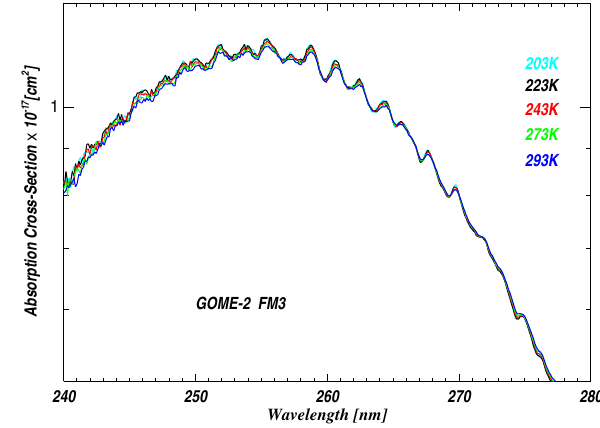
Fig. 1. Temperature dependent ozone absorption cross section spec- tra measured with the GOME-2 FM3 spectrometer (230–790nm). The cross section cover the Hartley, Huggins and the Chappuis bands and were recorded at 203, 223, 243, 273, and 293K.